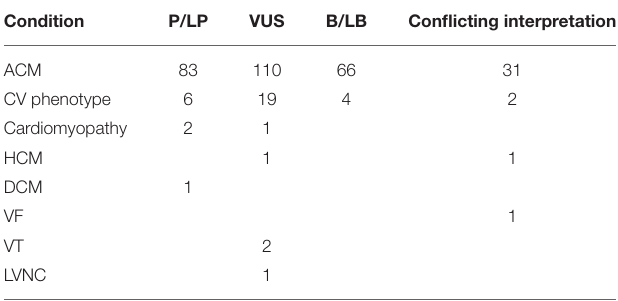
TABLE 1 | PKP2 variants reported in ClinVar related to different cardiac